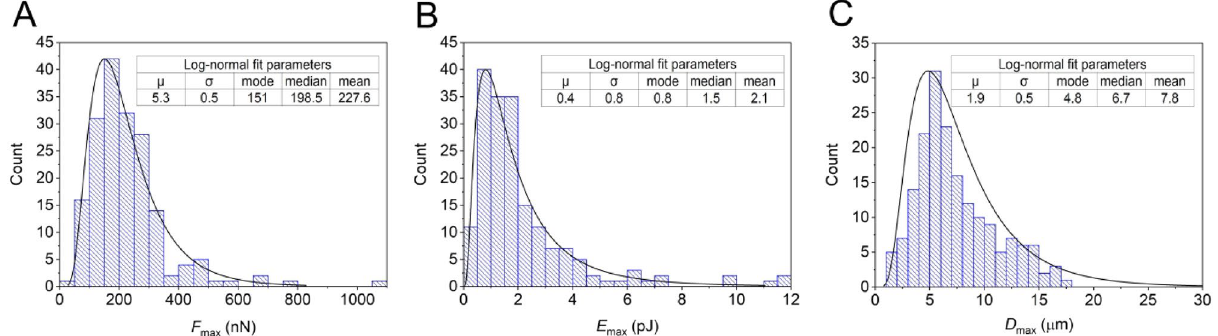
Figure 2. Force-distance curve parameters follow lognormal distribution for the overall population of 181 cells. Characteristic parameters recorded by SCFS are F max ( A ), E max ( B ), and D max ( C ), which provide information on the adherence of single cells. The lognormal fit parameters are summarized in the tables next to the histograms of individual